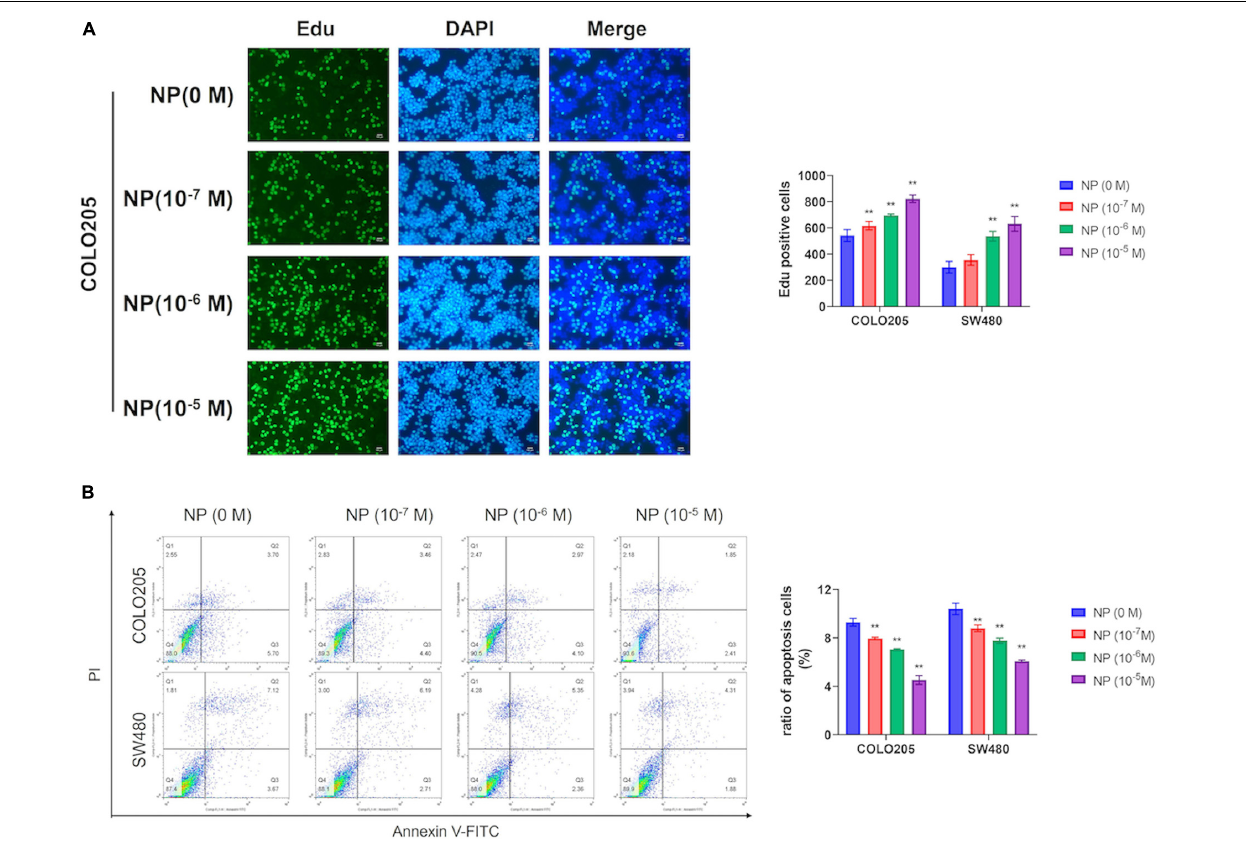
FIGURE 2 | Nonylphenol (NP) induces colorectal cancer (CRC) cell proliferation and inhibits cell apoptosis. (A) COLO205 and SW480 cells treated with different concentrations of NP (0, 10 − 7 , 10 − 6 , and 10 − 5 M) for 24 h and tested by 5-ethynyl-2 (cid:48) -deoxyuridine (EdU) assay. Bar = 100 µ m. Positive cells were measured, and the results are shown as bar charts. (B) NP treated COLO205 and SW480 cells stained with Annexin V-FITC/PI; cell apoptosis tested using flow cytometry. ** p < 0.01.